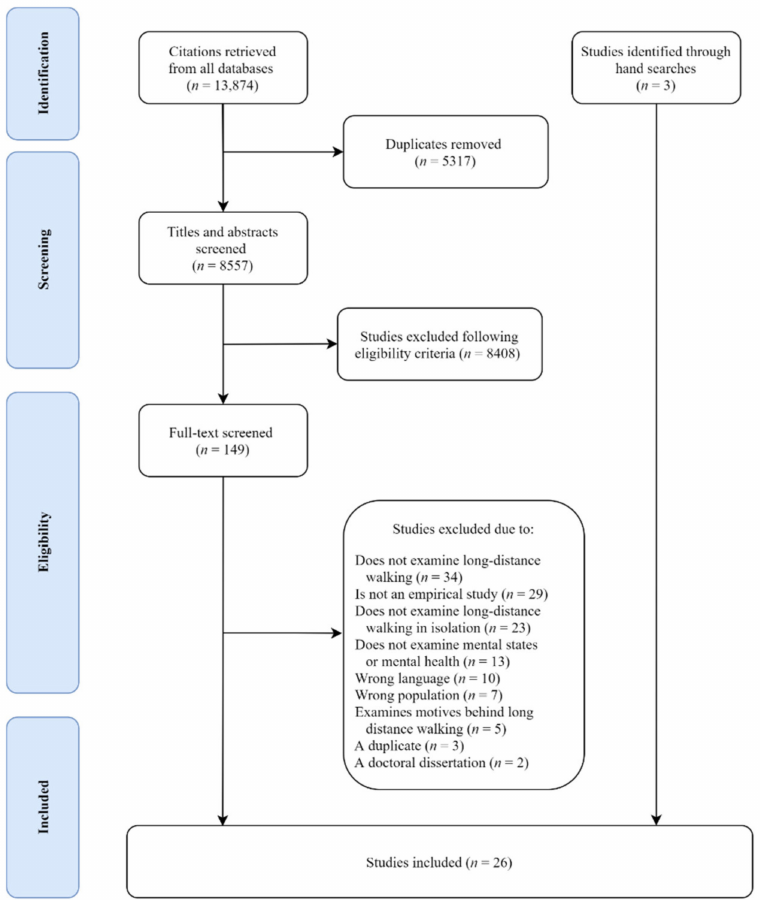
Figure 1. Flow chart illustrating the search process in a scoping review on long-distance walking and mental